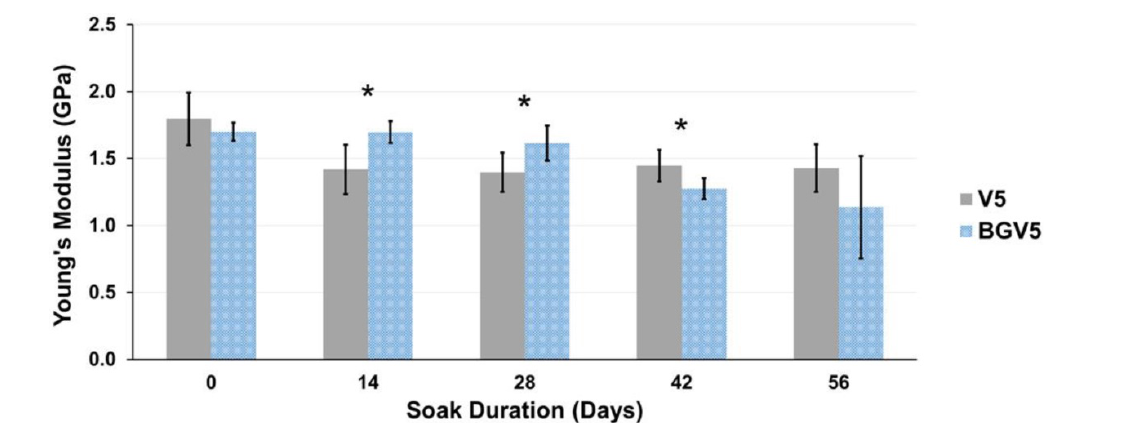
Figure 7. The Young’s moduli of V1, BG, and BGV1 over time. An asterisk (*) over a bar represents a significant difference (p<0.05) between the groups (n=5) at the ends of the bar. Error bars represent ± one standard deviation.